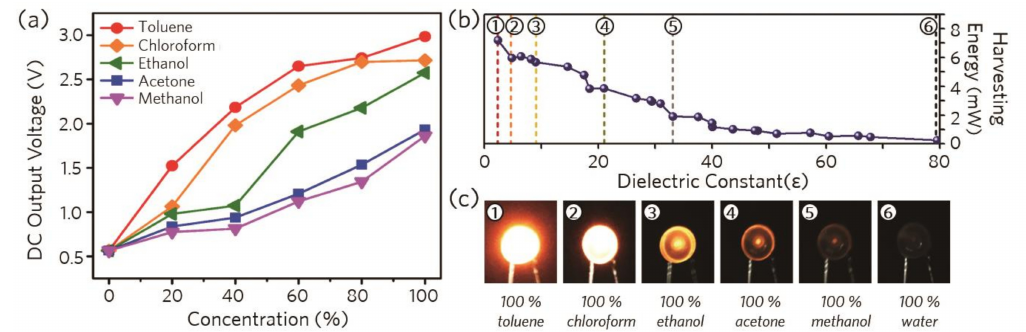
Figure 6. Experimental results for various chemical mixtures. ( a ) Measured DC output voltage of the Wi-Fi harvesting sensor for various concentrations of the chemical mixtures. ( b ) Measured harvesting energy and ( c ) corresponding brightness of the sensor for different dielectric constants of the chemical